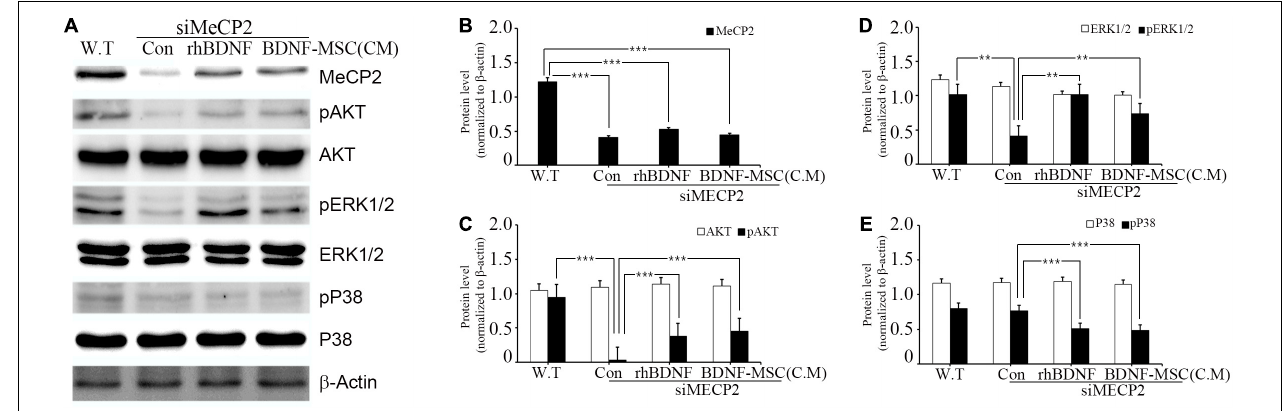
FIGURE 2 | Relative levels of MeCP2, AKT, and MAPK following rhBDNF or BDNF-MSC(CM) treatment in MeCP2 silenced cells. (A) Immunoblot analysis of the MeCP2 silenced cell lysates following rhBDNF or BDNF-MSC(CM) treatment. (B–E) Densitometry analyses of MAPK proteins evaluated using the Image-J software. Conditioned media from the control, si MeCP2 , BDNF-treated, and BDNF-MSC-treated groups were tested. The phosphorylation of AKT and MAPK (ERK1/2 and p38) indicates changes in cell signaling. β -actin was used as the standard. ** p < 0.01, *** p < 0.001.